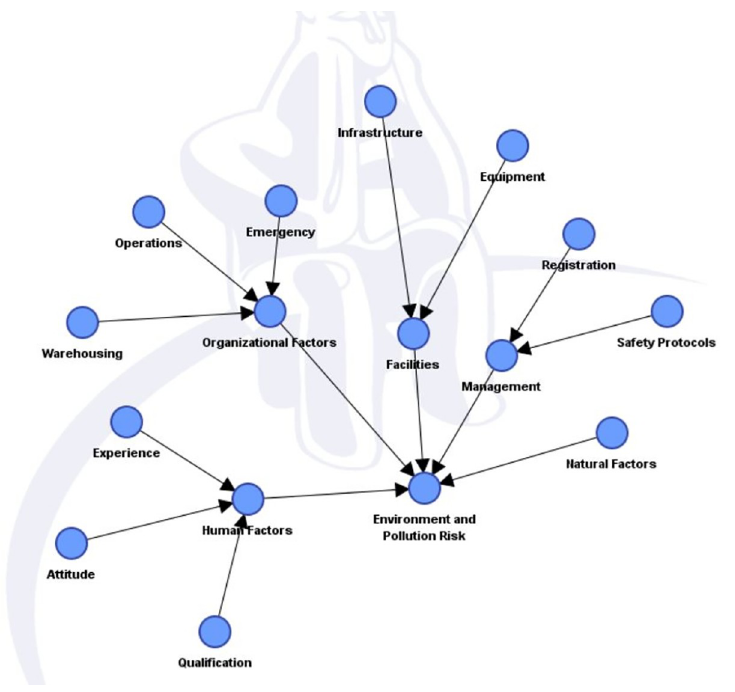
Fig 1. DAG of the developed